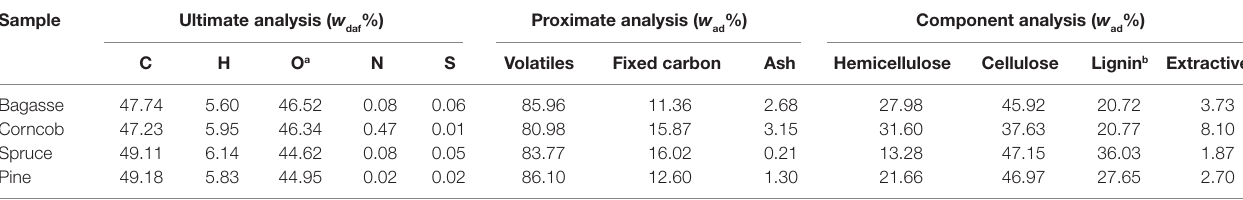
TaBle 1 | Ultimate, proximate, and chemical composition analysis of four biomasses.